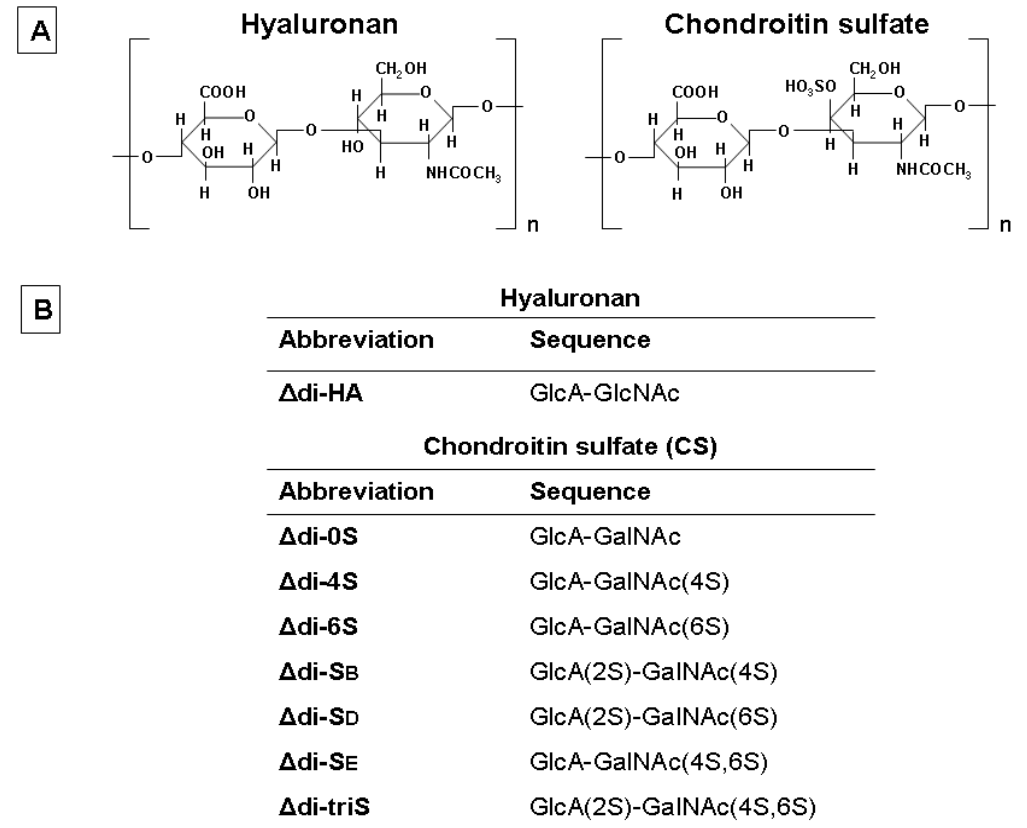
Figure 1. Typical structure of disaccharide units in hyaluronan and CS. Panel A : The backbone of hyaluronan ( left ) and CS ( right ) chains is a linear polymer composed of repeating disaccharide units, [-4GlcA β 1–3GlcNAc β 1-] and [-4(IdoAalpha/GlcAbeta) 1–3GalNAc β 1-], respectively. Panel B : Abbreviations and sequences of typical disaccharide units of hyaluronan and